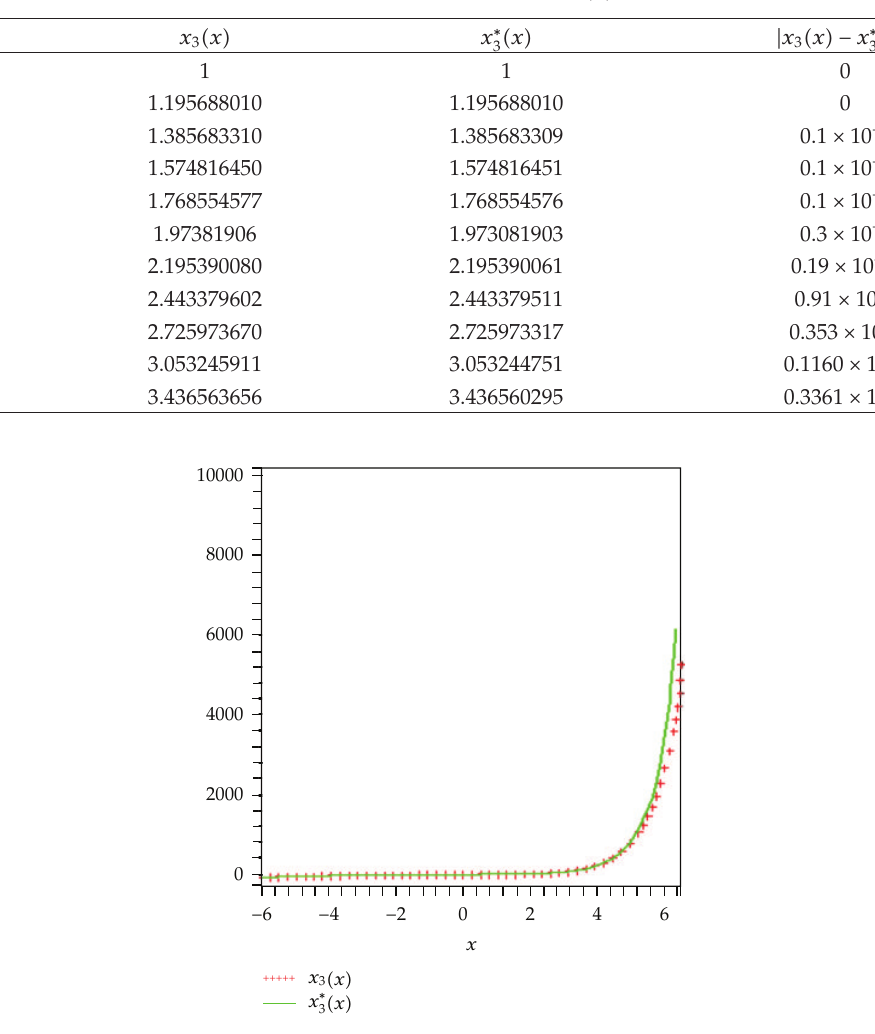
Figure 3: Values of x 3 (cid:3) x (cid:4) and its x ∗